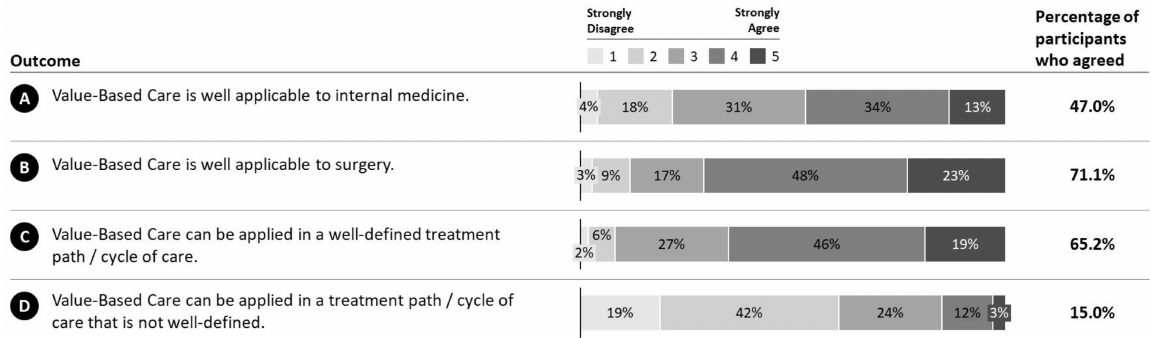
Figure 5. Category outcome. Responses of participants along the VBC category outcome. A : VBC applicability to internal medicine. B : VBC applicability to Surgery. C : VBC applicability to well- defined cycle of care. D : VBC applicability to not well-defined cycle of care.